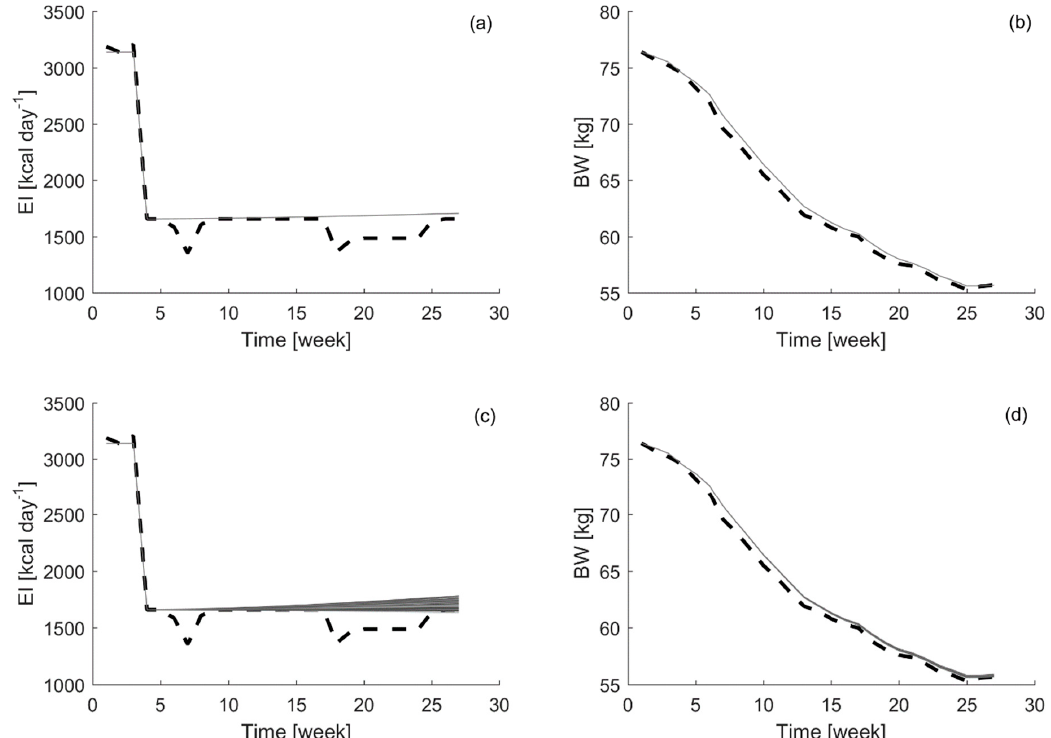
Figure 6. Energy intake curves suggested by the MPC system based on the time-invariant parameters TF model when uncertainty is added to the a-parameter estimation ( a ) or in b-parameter estimation ( c ) and the obtained bodyweight curves when following these respective energy curves ( b ) and ( d ), after 100 Monte Carlo simulations are performed.